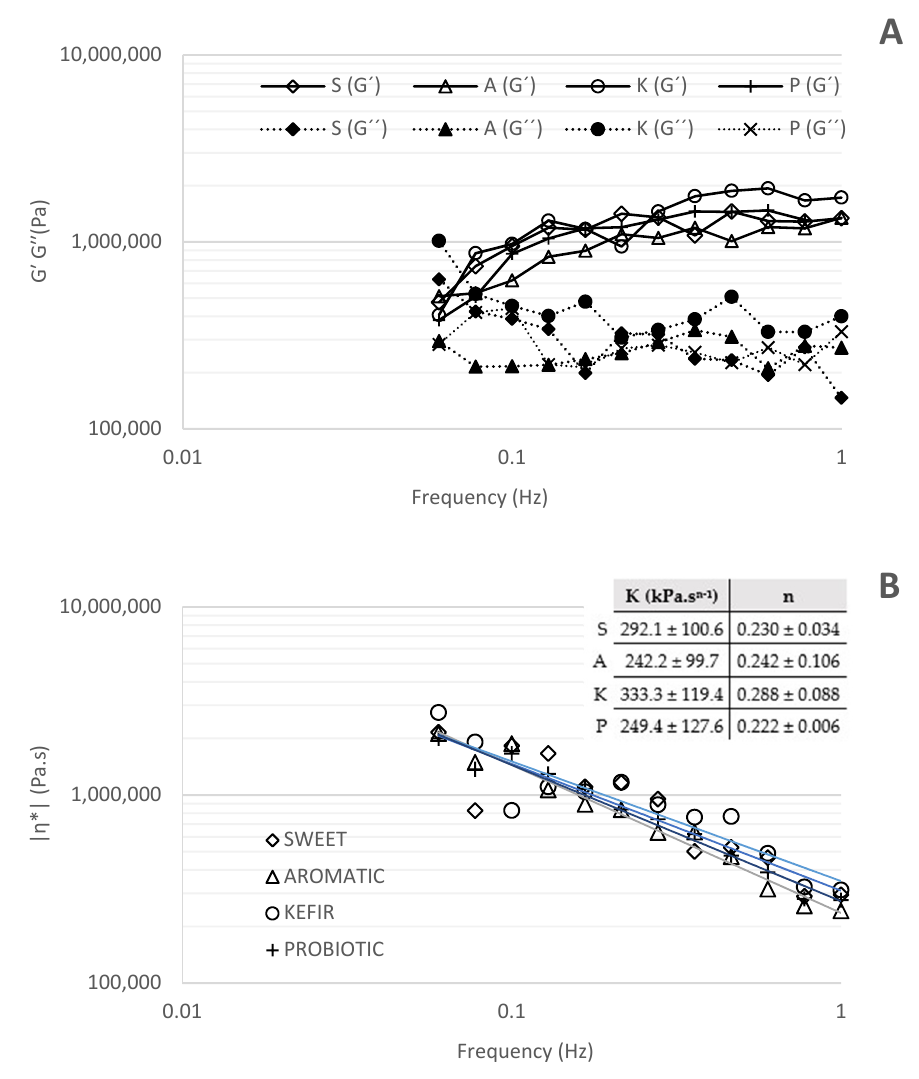
Figure 2. Rheological parameters of sheep ′ s butters produced with sweet cream (S) and cream fermented with aromatic starter culture (A), kefir (K) and probiotics (P). ( A ) Elastic (G ′ ) and viscous (G ″ ) moduli; ( B ) complex viscosity. According to power law model (Equation (2)) consistency index ( K ) and power law index ( n ).